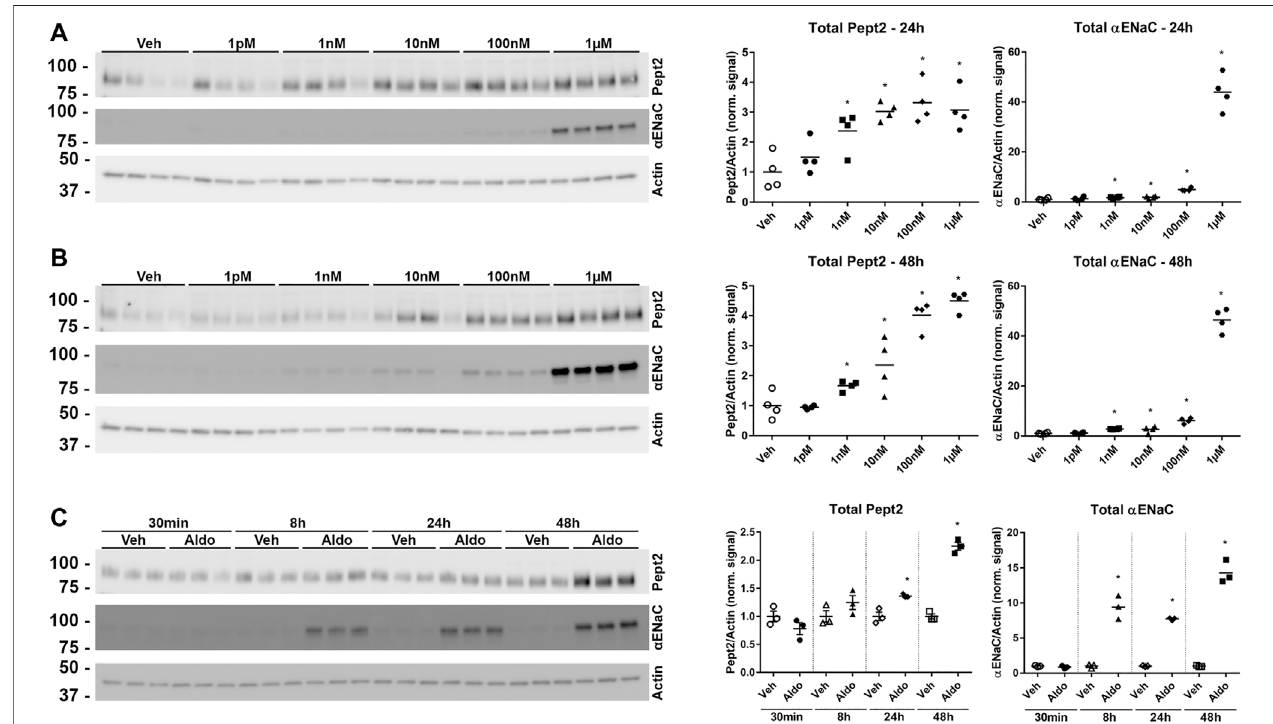
FIGURE5| Pept2isanaldosteroneinducedprotein. (A) mpkDCTcellsstablytransfectedwithwild-typemouseFLAG-tagged-Pept2(WTPept2)weretreatedwith vehicle(DMSO)orincreasingconcentrationsofaldosteronefor24 h.Sampleswereprobedwithantibodiesagainstactin, α ENaCandFLAG(detectingPept2). (B) Similar experimentbut48 htreatment. (C) IncreasesinPept2inmpkDCTcellsinresponseto1 µMaldosteroneovertime.* p < 0.05inunpaired t -testversusvehicletreatmentof same cell line.